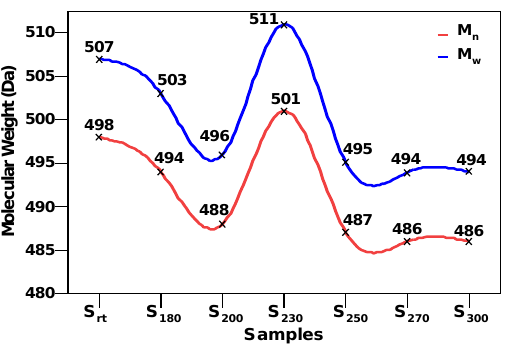
Figure 2. Molecular weight distributions of S rt , S 180 , S 200 , S 230 , S 250 , S 270 , and S 300 .